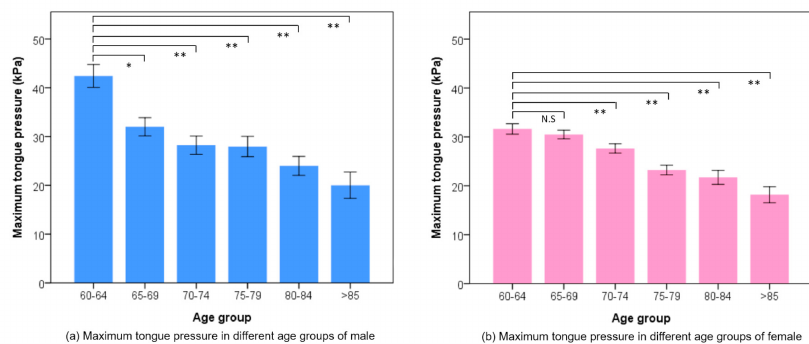
Figure 2. The mean maximum tongue pressure of ( a ) male and ( b ) females among age groups. Each bar showed the mean value and standard error. * p < 0.05, ** p < 0.01. N.S.: